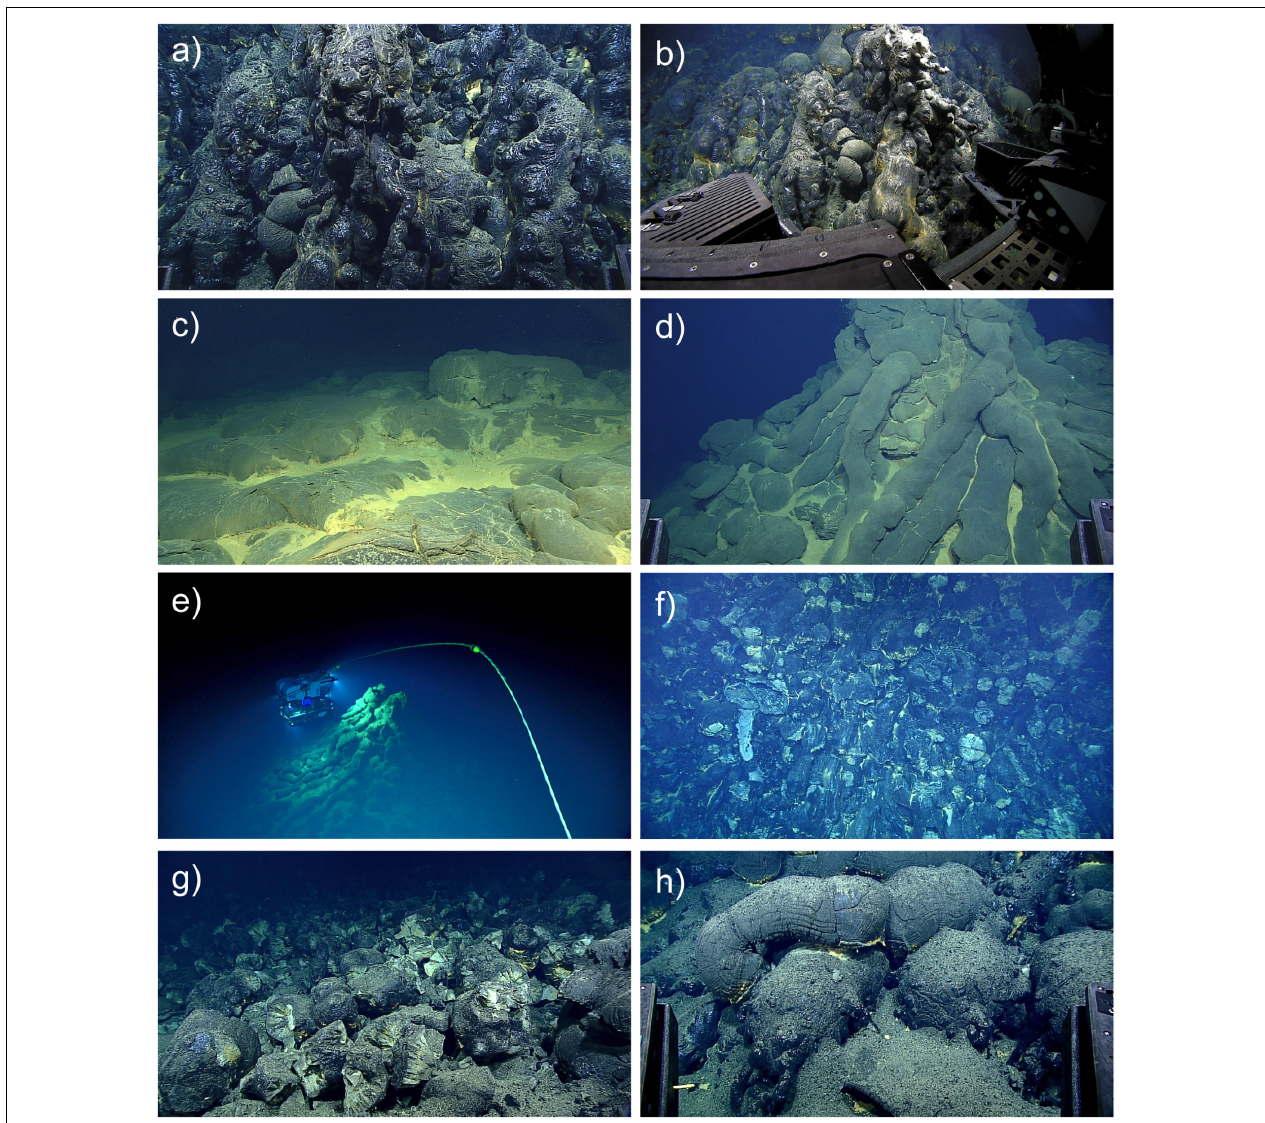
FIGURE 8 | Images from ROV Deep Discoverer dive EX1605L1-09 on 29–30 April 2016, which crossed the northern-most and thickest of the 2013–2015 lava flows. See Figure 7 for photo locations. Numbers in parentheses are time of photo in GMT and horizontal scale. (a) Pillow lavas with extremely glassy finger-like buds (03:41:31, 2 m). (b) ROV set up to sample a glassy pillow bud (03:49:32, 4 m). (c) Broader lobes on top of one of the pillow mounds with hydrothermal sediment (00:03:48, 5 m). (d) Conical eruptive center at the top of a mound with radiating pillow tubes and hydrothermal sediment (02:43:00, 6 m). (e) View of ROV illuminating a conical eruptive center (02:40:20, 20 m). (f) Nearly vertical cliff with intact and truncated pillows (01:12:11, 10 m). (g) Primary pillow talus at base of cliff (01:06:06, 3 m). (h) Fragmental deposit on top of pillows beyond the talus apron (01:03:14, 2